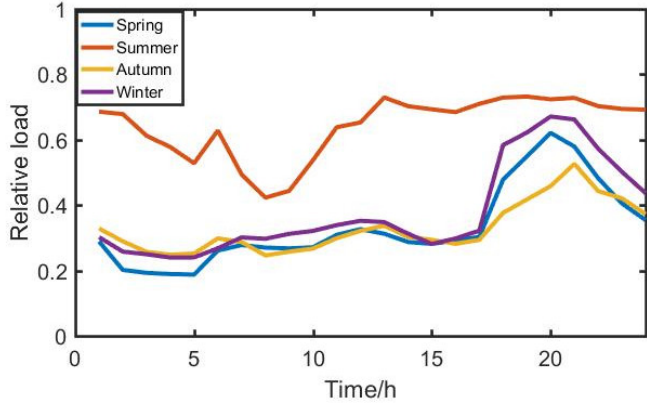
Figure 5. Civil load time series characteristic curve.